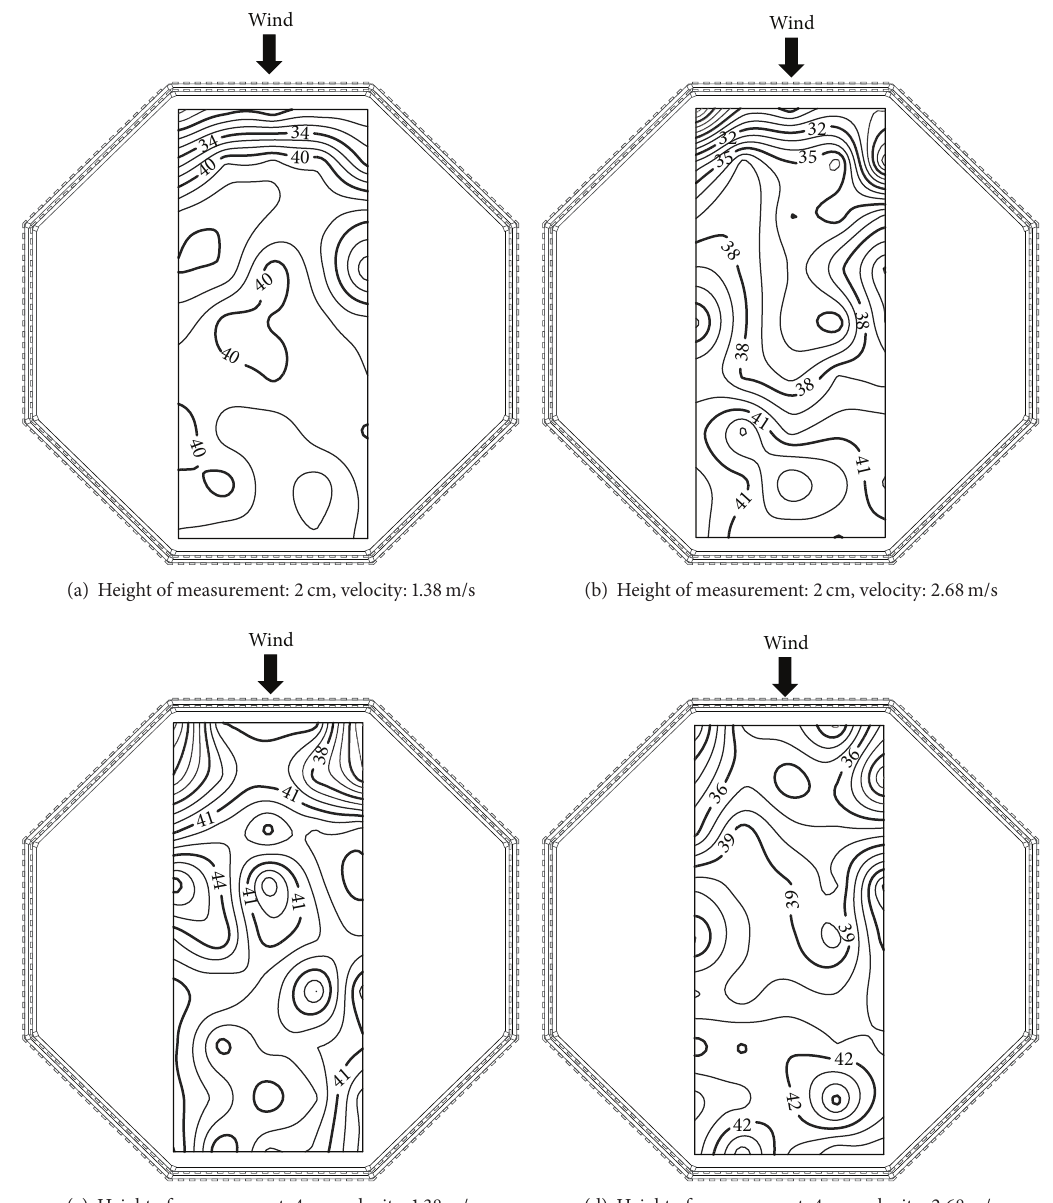
Figure 20: Distribution of the turbulence intensity inside the windbreak fence (CASE